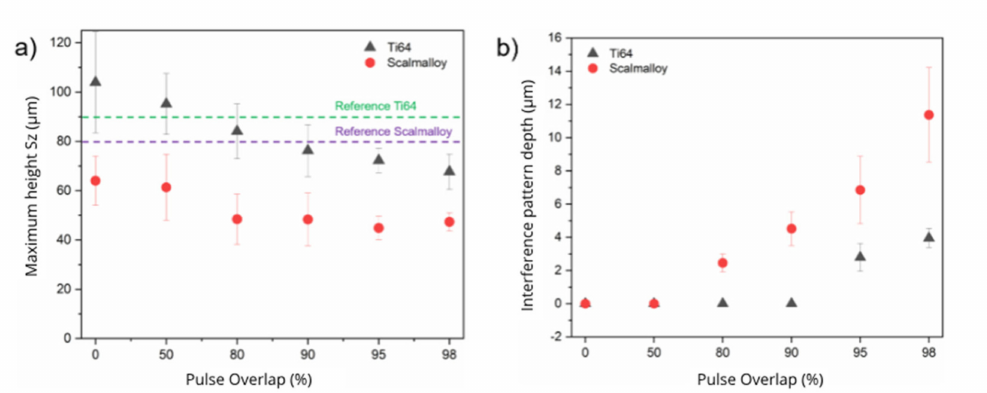
Figure 4. ( a ) Surface roughness Sz and ( b ) interference pattern depth as a function of the pulse overlap for the DLIP-treated titanium and aluminium alloys. The used laser fluence was 3.2 J/cm 2 for all